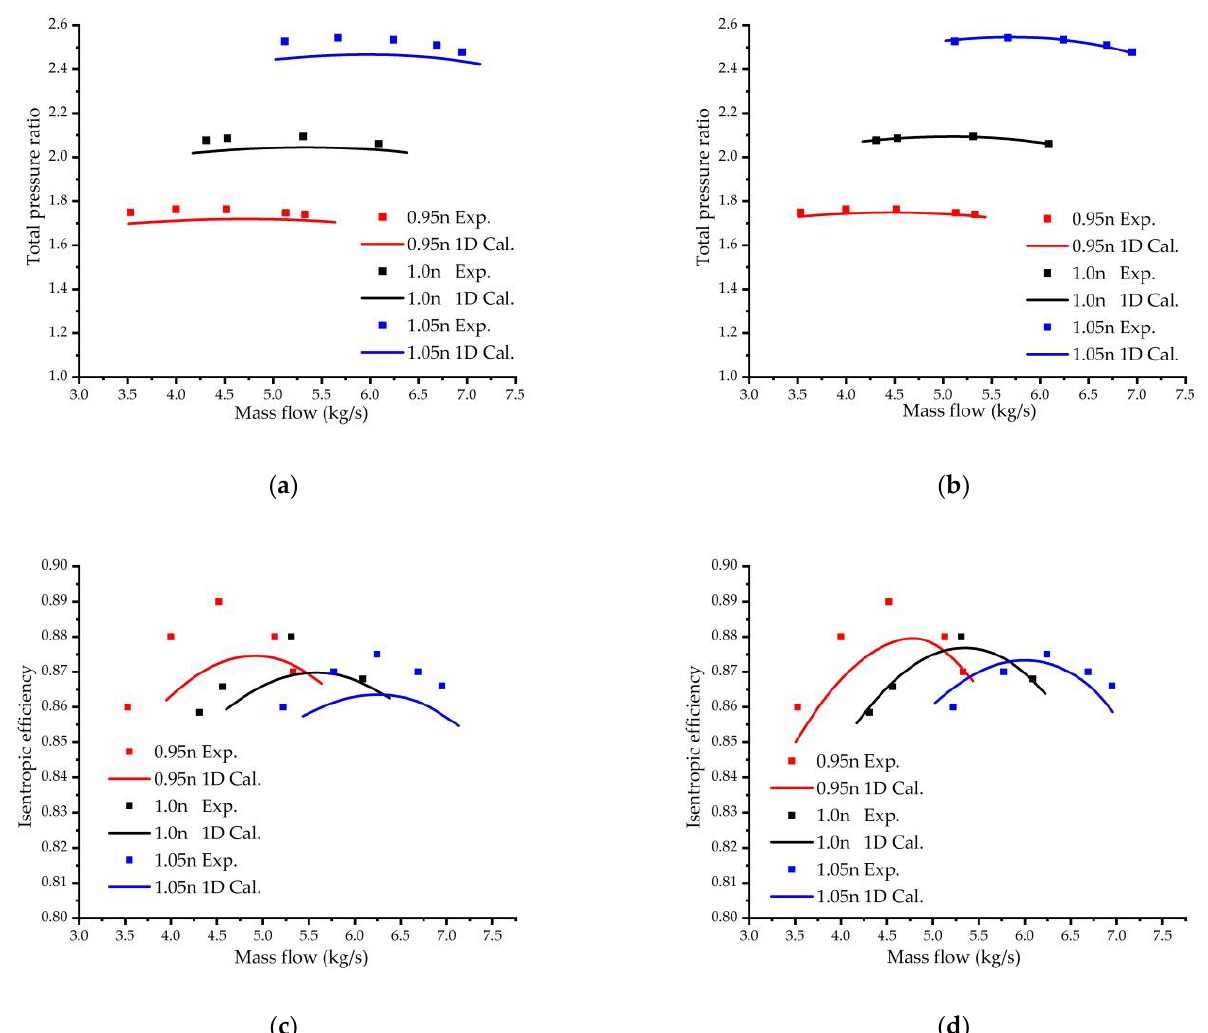
Figure 12. Comparisons of the 1D predicted performance before and after optimization for the Eckardt-O impeller: ( a ) Total pressure ratio before optimization; ( b ) Total pressure ratio after optimization; ( c ) Efficiency before optimization; ( d ) Efficiency after optimization.